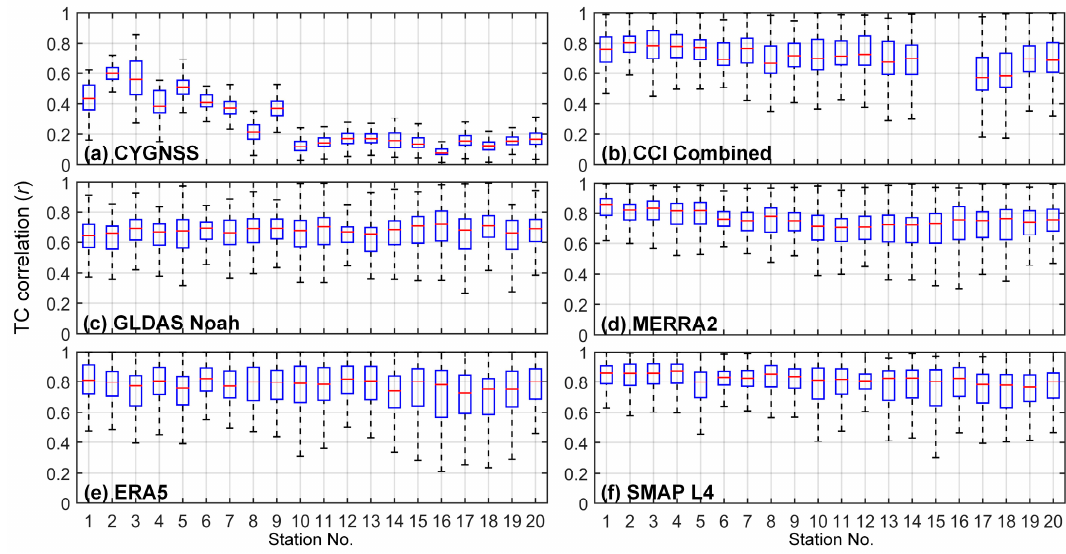
Figure 6. TC-based R values of the six soil moisture products at the 20 stations. Each boxplot shows the distribution of R values derived from all triplets, including ( a ) CYGNSS SM, ( b ) CCI Combined SM, ( c ) GLDAS Noah SM, ( d ) MERRA2 SM, ( e ) ERA5 SM and ( f ) SMAP L4 SM.